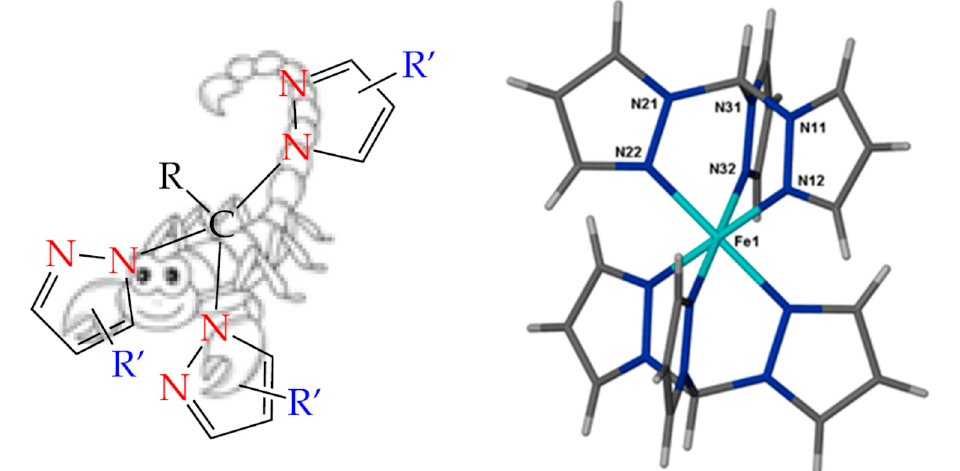
Figure 1. Schematic structure of C-scorpionate tris(pyrazol-1-yl)methanes RC(R ′ -pz) 3 (pz = pyrazolyl; R = H or substituent at the methine carbon; R ′ = H or any substituent at the pz ring) and comparison with a scorpion; and the structure of the complex cation [Fe(HC(pz) 3 } 2 ] 2+ .